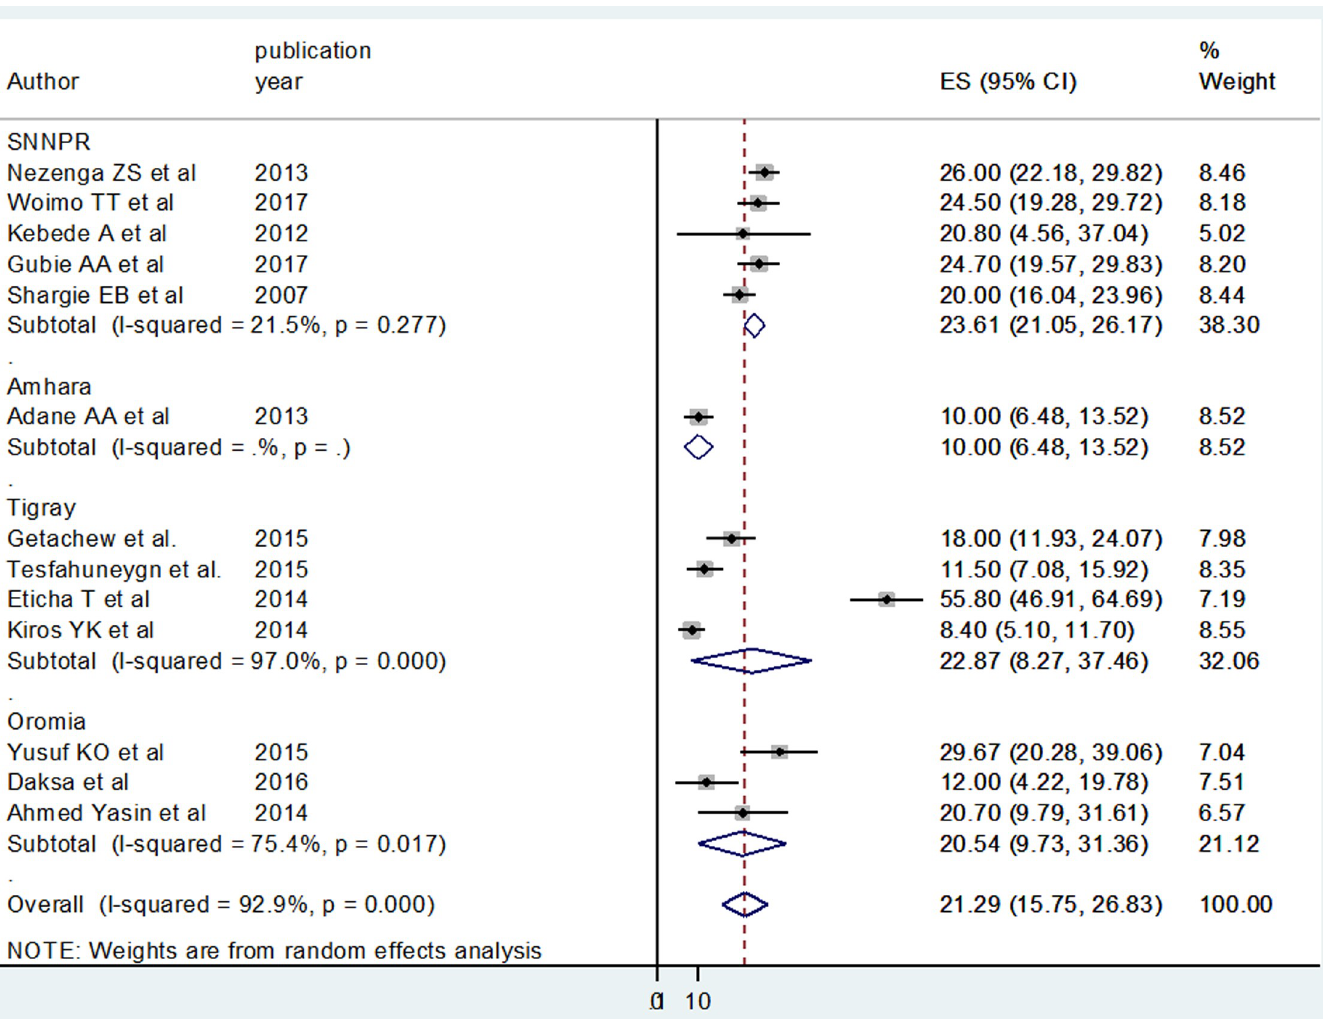
Fig 4. Forest plot depicting subgroup analysis of non-adherence to anti TB medication in Ethiopia according to the location of the studies assessed.